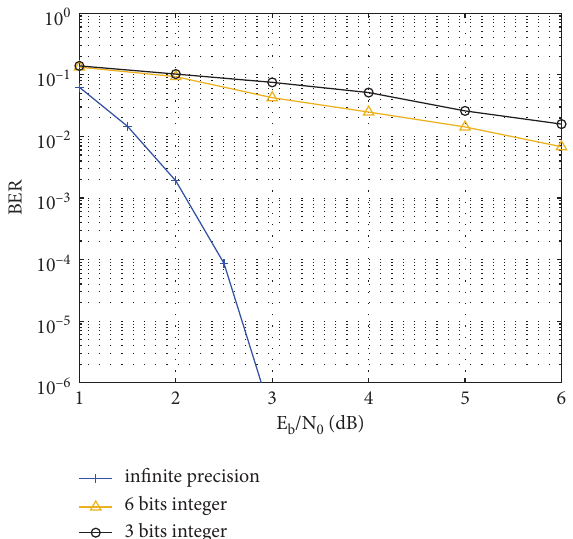
Figure 7: Efect of integer quantization on SPA decoding. Te block length and code rate of LDPC code are n � 1008 bits and R � 1/2, respectively.